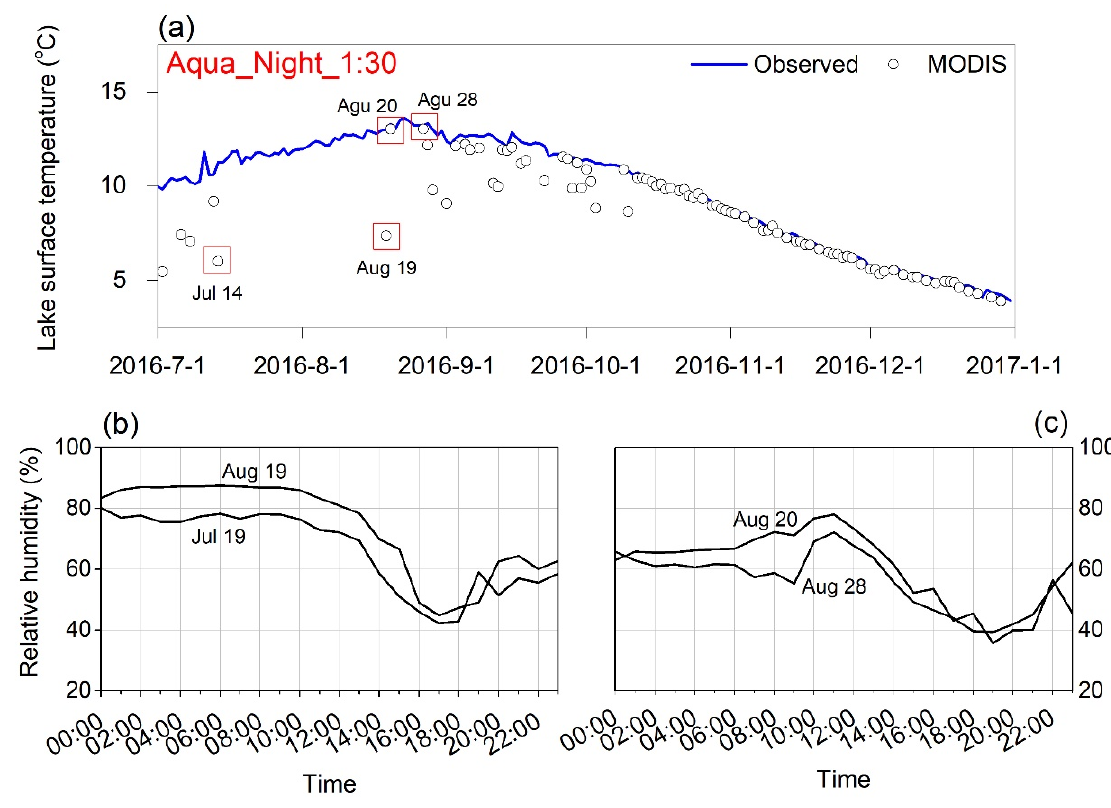
Figure 6. Comparison of MODIS Aqua and in-situ measurements of nighttime LSWT on Lake Peiku Co, (located in Himalaya region) ( a ), the diurnal variation in relative humidity on 14 July 2016 and 29 August 2016 ( b ) and 20 August 2016 and 28 August 2016 ( c ). On these two days in panel ( b ), MODIS LSWTs showed large negative deviations from the in-situ measurements, and the opposite in panel ( c ), indicated by the four red rectangles in part ( a ).